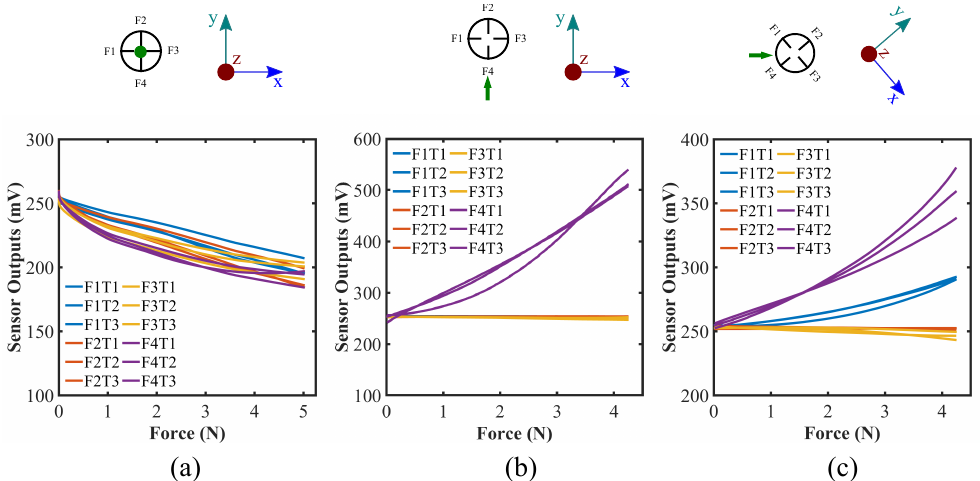
Figure 11. Repeatability test for force calibration for the forces along ( a ) z-axis, ( b ) y-axis, and ( c ) 45 ◦ angle from the x-axis; sensor responses for all three trials for each case are shown in the graphs accordingly; green dot and arrow represent the force directions; top view of the sensor system is also